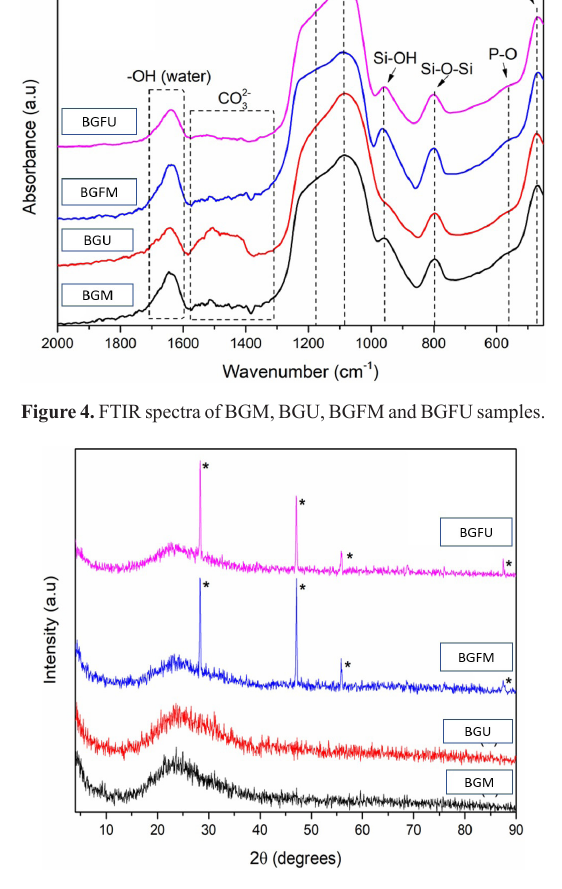
Figure 5. XRD patterns of (a) BGM; (b) BGU; (c) BGFM; and (d) BGFU